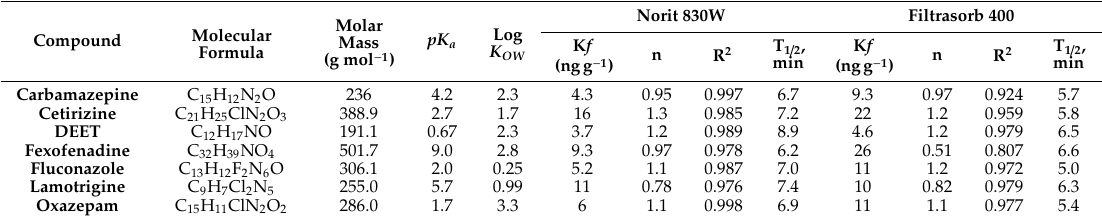
Table 1. Compound name, molecular formula, molar mass, acid dissociation constant (pK a ), log octanol / water partition coe ffi cient (K ow ) and T 1 / 2 (half-life time, min) of concentration in the aqueous phase, and Freundlich adsorption coe ffi cient (Kf) for the seven selected organic micropollutants (OMPs) onto two di ff erent granulated active carbon (GAC) types (Norit 830W and Filtrasorb 400). Compound Molecular